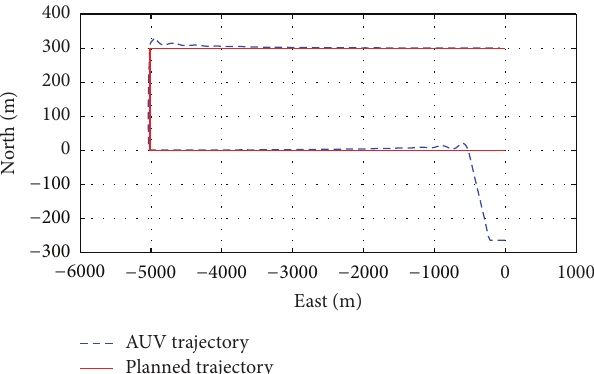
Figure 3: The trajectory following control with 0.5 knot